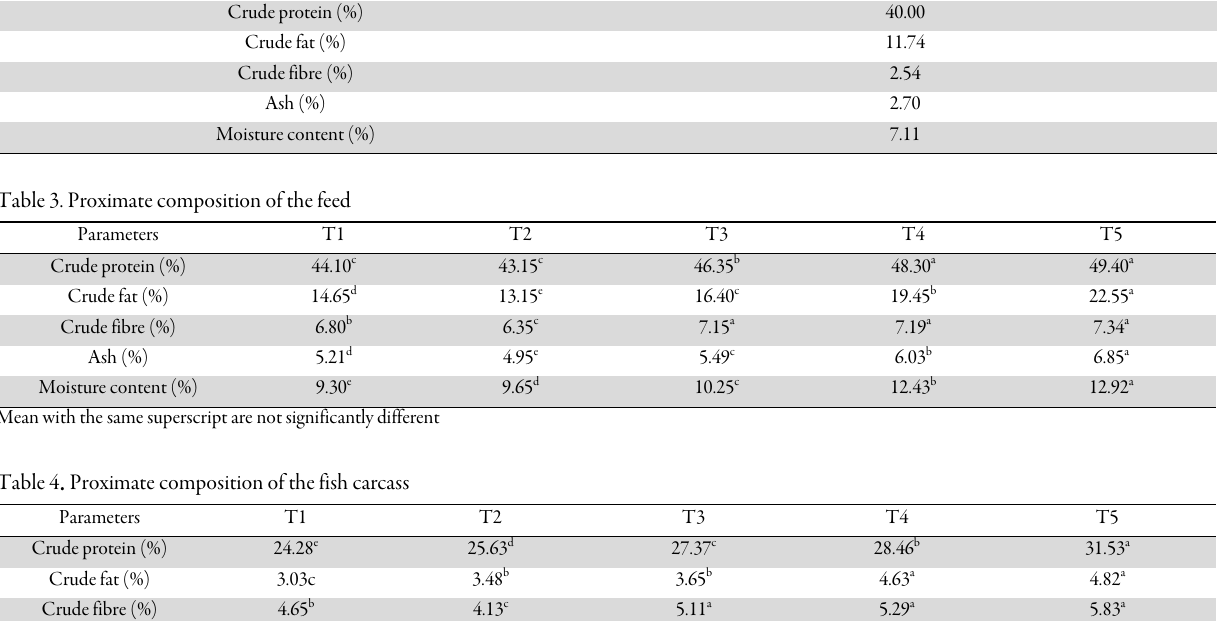
Table 2. Proximate composition of the poultry droppings Parameters